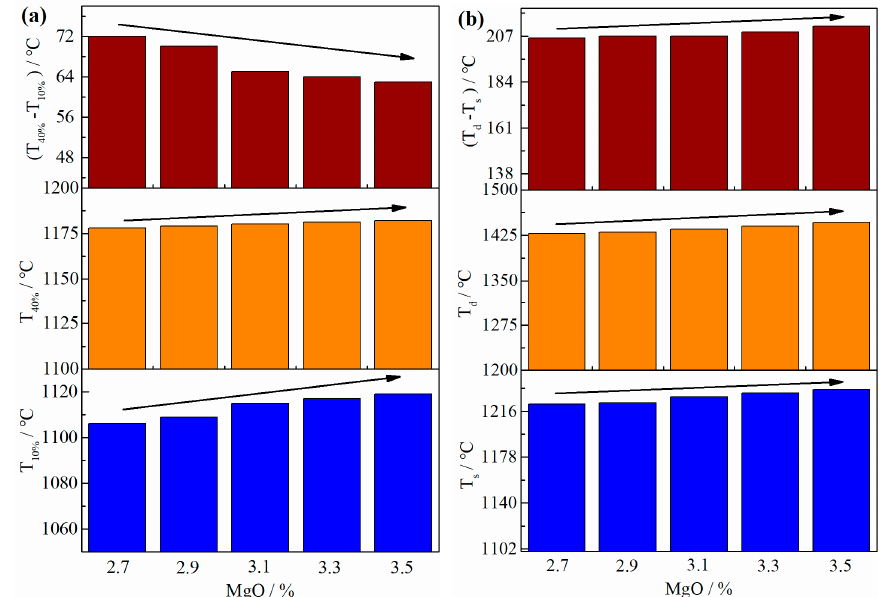
Figure 9. The softening-melting properties of the HCVTM sinter with different MgO contents (a) softening property; (b) melting property.